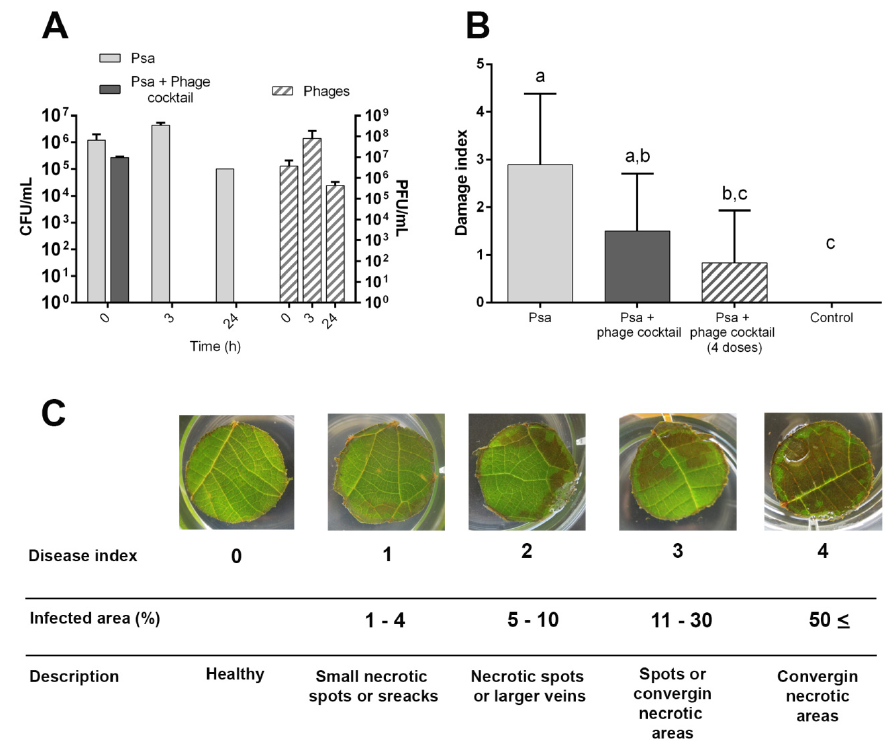
Figure 4. Efficacy of Chilean Psa phages to control Psa in vitro. ( A ) The bacterial Psa load present in leaf discs inoculated with Psa (Light gray) or Psa + phage cocktail (dark gray) after 24 hpi incubation in humidity chambers ( n = 3). Striped bars represent the phage concentration in leaf discs inoculated with the Psa + phage cocktail. ( B ) The damage index in kiwifruit leaf discs 3 days post-infection with Psa or with the Psa + phage cocktail. Phages were added with a MOI of 10, 1 h (Psa + phage cocktail) or 1, 24, 48, and 72 h (Psa + phage cocktail (4 × doses)) post-infection with Psa. Leaf discs not infected with Psa were used as the control. Phage cocktail: CHF1, CHF7, CHF19, and CHF21. Standard deviation bars are shown. The letters indicate significant differences using one-way ANOVA and Tukey’s multiple comparisons test ( p ≤ 0.05) ( n = 18). ( C ) The visual pattern of the damage index used to evaluate the experiment.